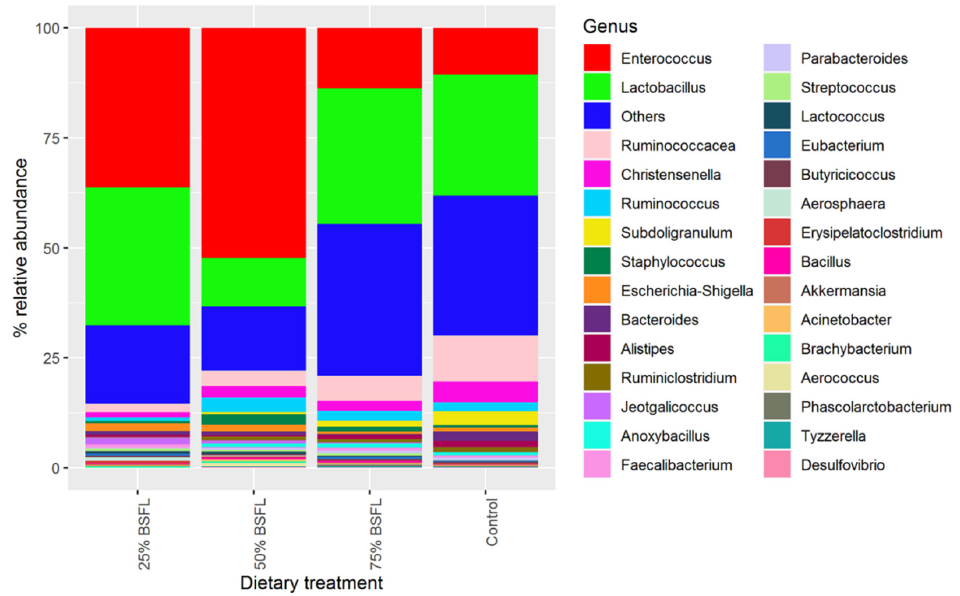
Figure 3. Cumulative relative composition of bacteria operational taxonomic units at genus level observed across the different dietary treatments. The top 30 genera with high abundance were selected to calculate the relative abundance.